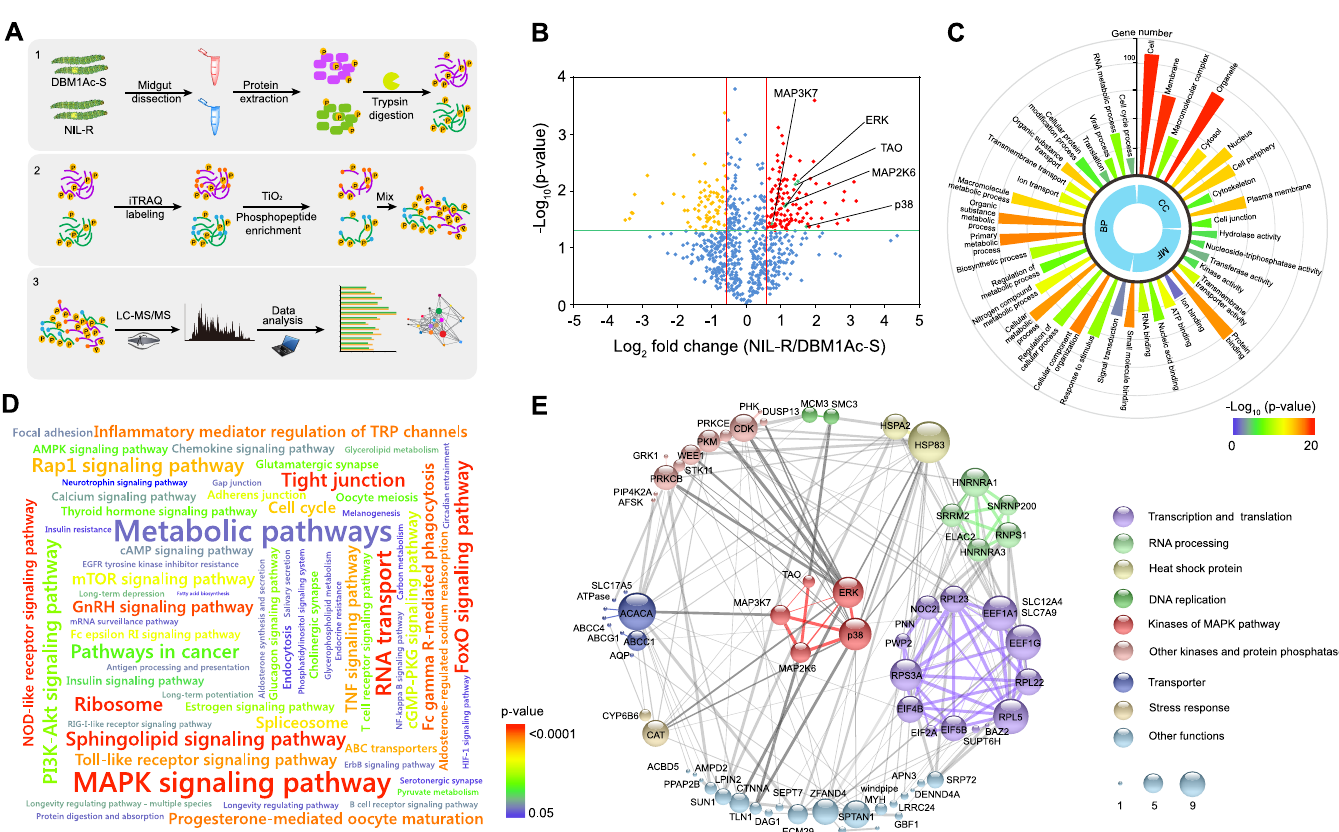
Fig 2. Quantitative phosphoproteomic profiling for differentially phosphorylated proteins and their interaction relationships in Cry1Ac susceptible and resistant P . xylostella strains. (A) Workflow of the experimental procedure for iTRAQ global phosphoproteome analysis. All the control larval samples used in phosphoproteome analysis were without Cry1Ac exposure to detect basal differentially phosphorylated proteins between resistant and susceptible strains. (B) Volcano plot of the abundance changes of qualified phosphoproteins in DBM1Ac-S versus NIL-R strains. Each dot represents a phospho-peptide. Average phospho-peptide expression ratio of three biological replicates (log 2 transformed) was plotted against p-value by t-test ( − log 10 transformed). Cutoff of P = 0.05 and 1.5-fold change were denoted by green and red lines, respectively. Some of the significantly up-regulated MAPK cascade kinases (P � 0.05, fold change � 1.5) are highlighted. (C) GO term enrichment for the significantly changed phosphoproteins. (D) KEGG pathway enrichment for the significantly changed phosphoproteins. Enriched KEGG pathways are visualized as a word cloud. The size of the word corresponds to the gene abundance in that category. (E) Connectivity network of significantly changed phosphoproteins. The original protein-protein interaction data comes from the STRING database. The size of the circles denotes the frequency of interactions. The thickness of the lines denotes the score of the interactions. Interactions among MAPK cascade kinases are shown by red lines, while interactions among MAPK cascade kinases and other proteins are shown by dark grey lines, all other interactions are shown in light grey lines.